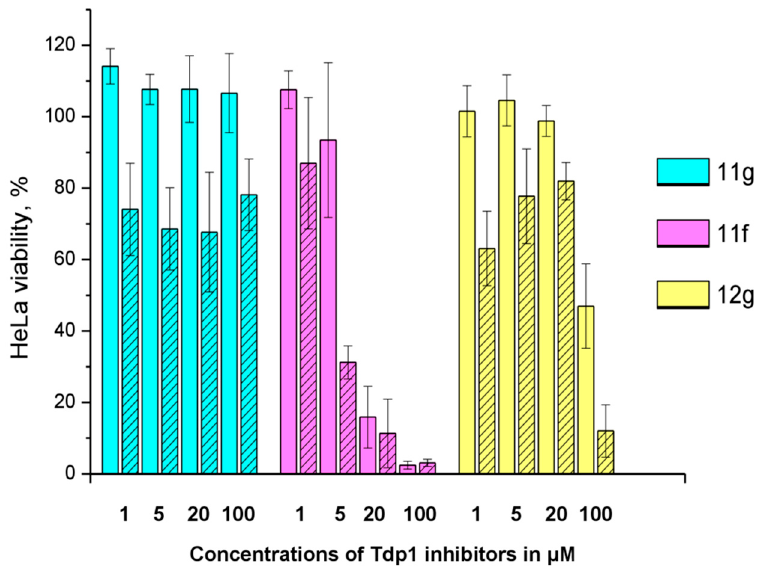
Figure 5. The influence of 2 µM topotecan on Tdp1 inhibitors’ cytotoxicity. The unshaded histogram bars denote cell viability in the presence of a Tdp1 inhibitor. The hatched histogram bars indicate cell viability in the presence of a combination of a Tdp1 inhibitor with 2 µM of topotecan. The concentration of the Tdp1 inhibitor in µM is given under each pair of bars. Error bars show standard deviations.